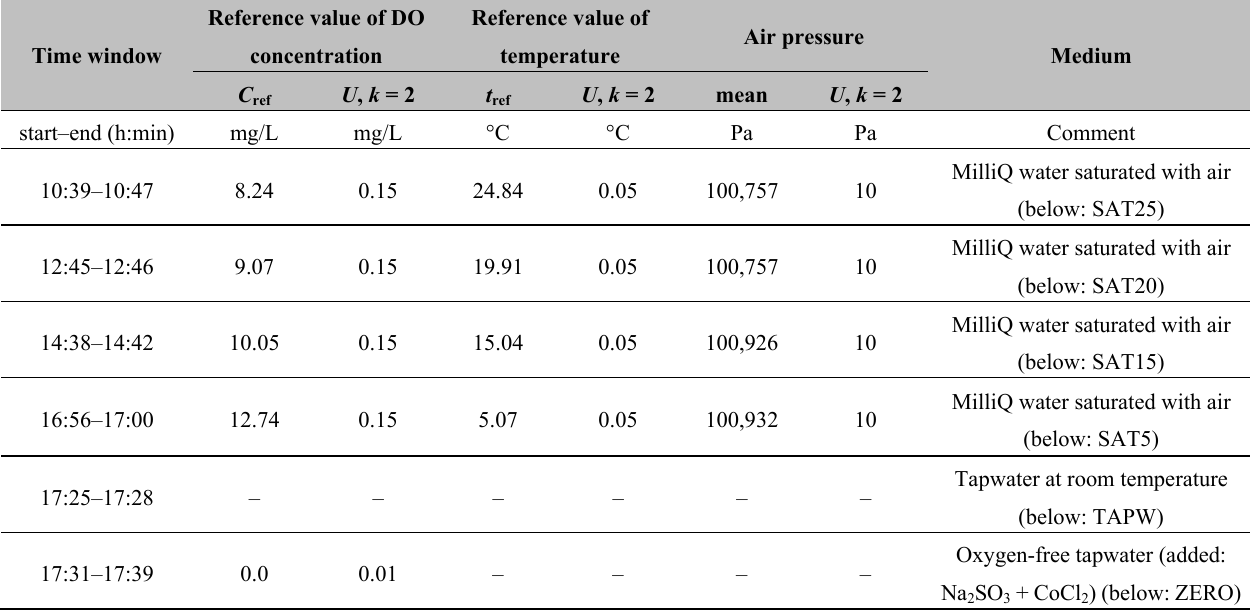
Table 1. Timetable, reference values and